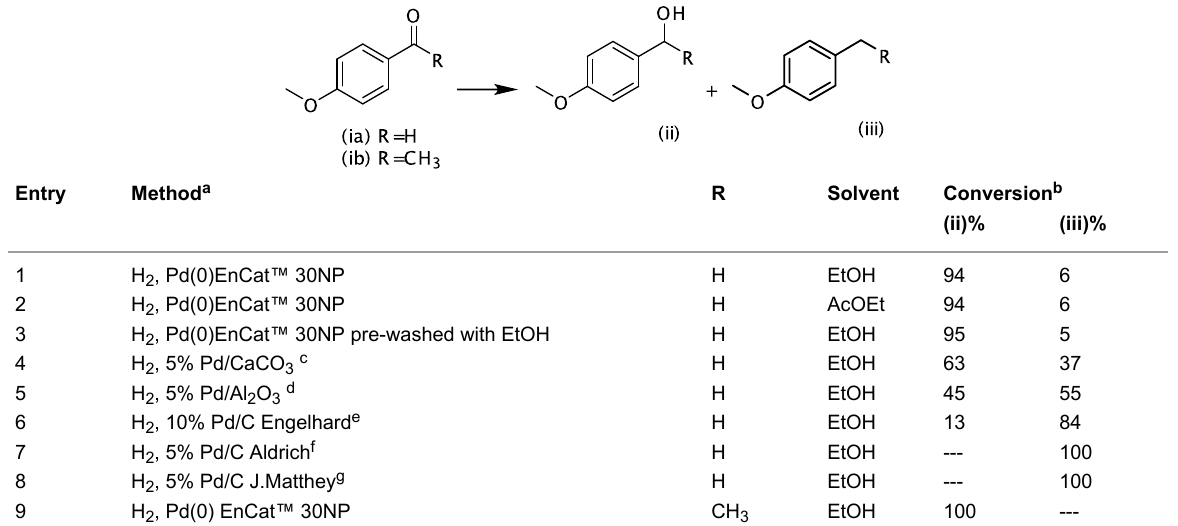
Table 1: Pd(0)EnCat™ 30NP-catalyzed hydrogenation of 4-mathoxybenzaldehyde and 4-methoxyacetophenone. Comparison with other Pd catalysts.